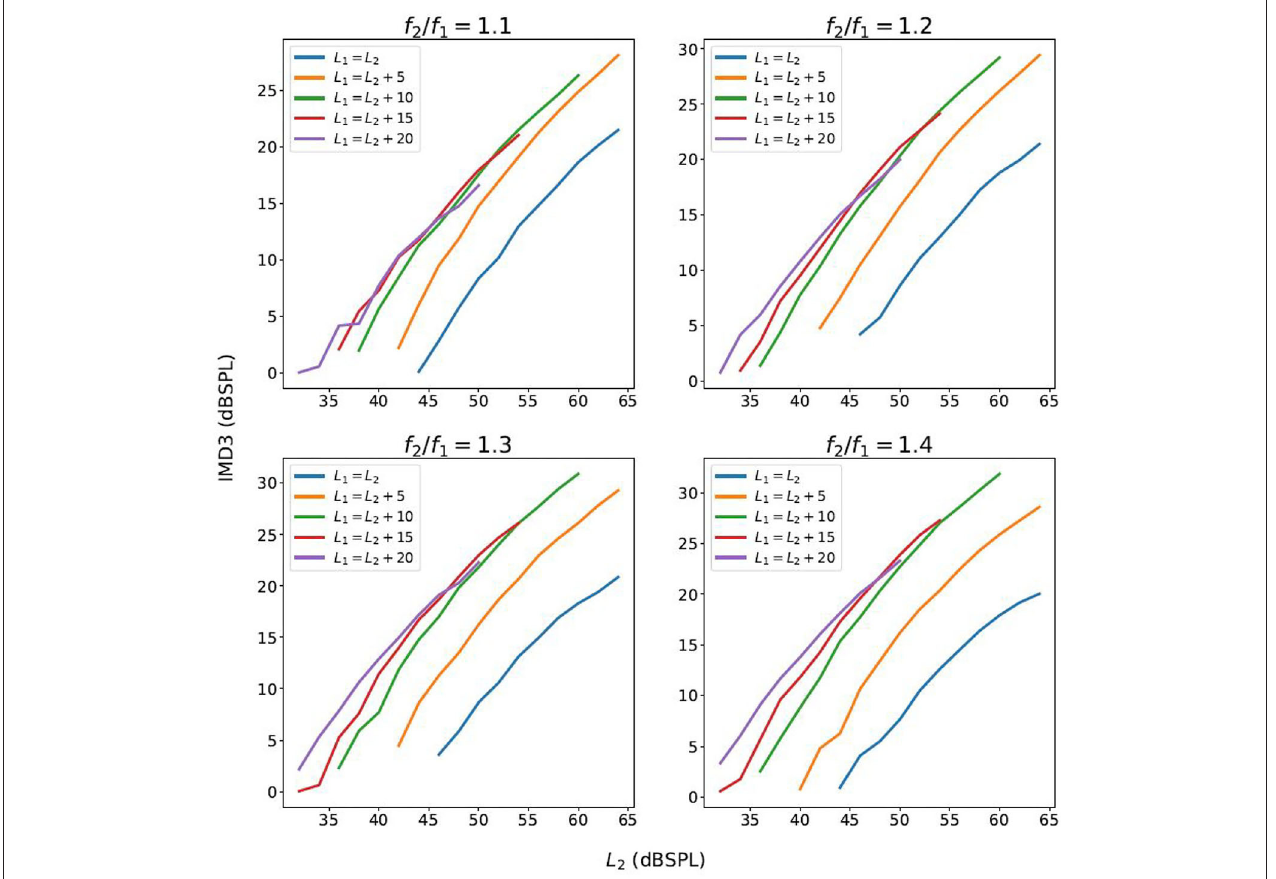
FIGURE 3 | The growth function of the IMD3 level with respect to L 2 , as L 1 and L 2 increase proportionately.